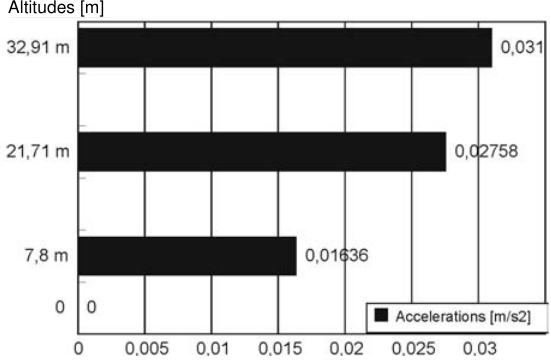
Fig. 8. The distribution histogram of accelerations along the vertical axis of the Belfry, while the bells operate all together